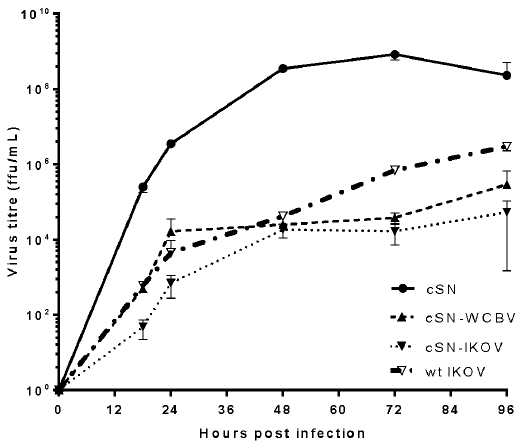
Figure 1. Growth kinetics of recombinant lyssaviruses in vitro. Multiple step growth curves of each virus starting from MOI 0.01.